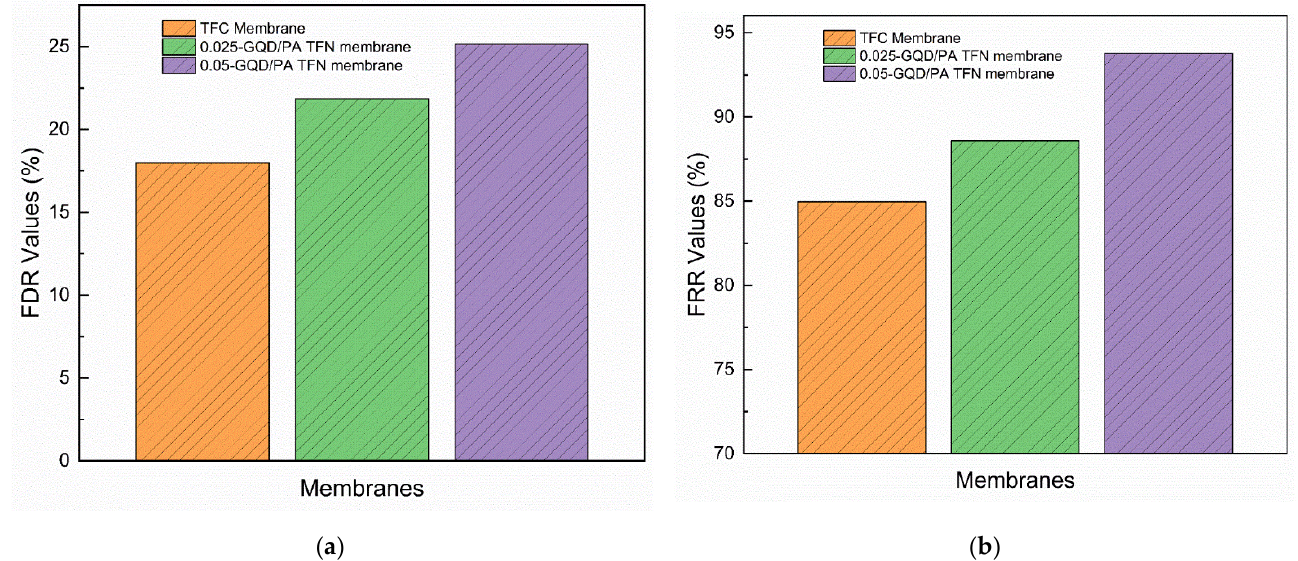
Figure 15. ( a ) Total flux decline ratio (FDR) values of TFC and GQD-based membranes during the fouling study. ( b ) Flux recovery ratio (FRR) values of TFC and GQD-based membranes during the fouling study.